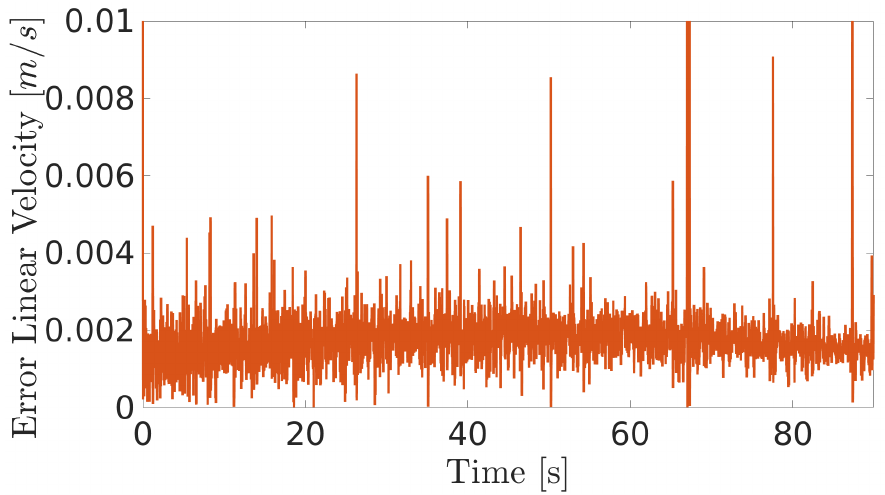
Figure 15. Linear velocity error of the robot when climbing the inner surface of the LPG tank.